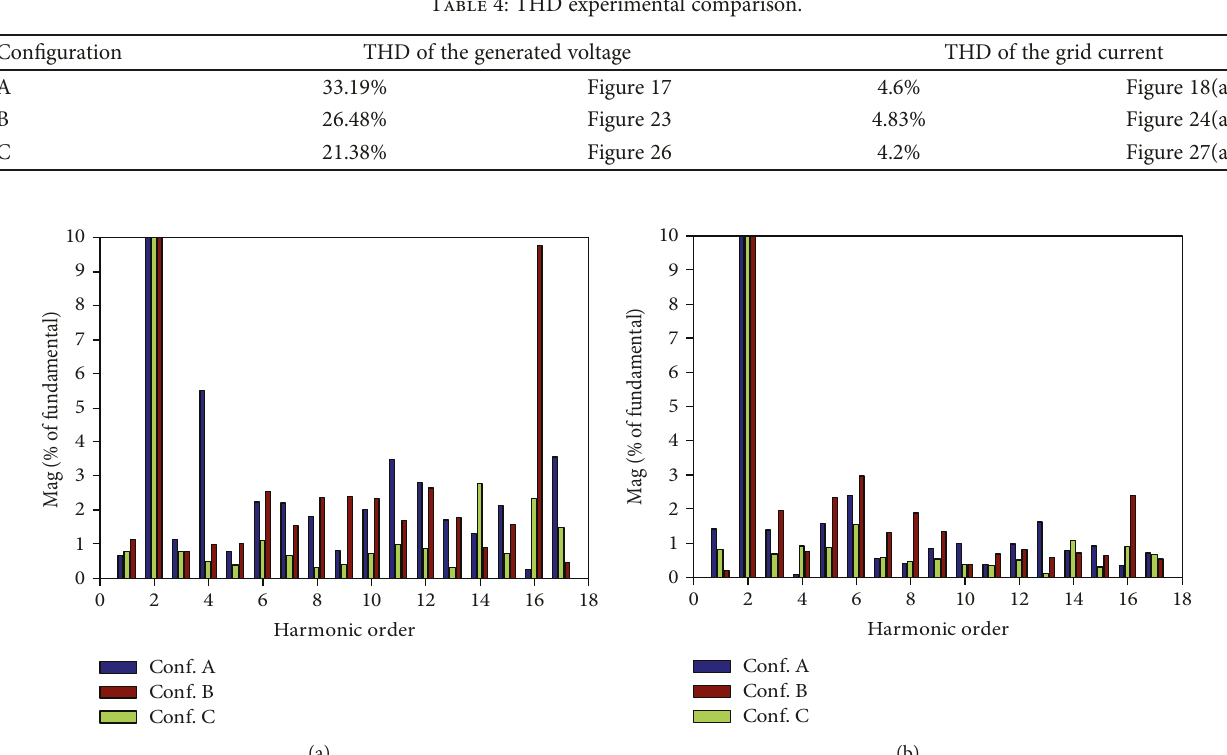
Figure 29: (a) Experimental harmonic spectrums of voltage generated. (b) Experimental harmonic spectrums of grid current ( I